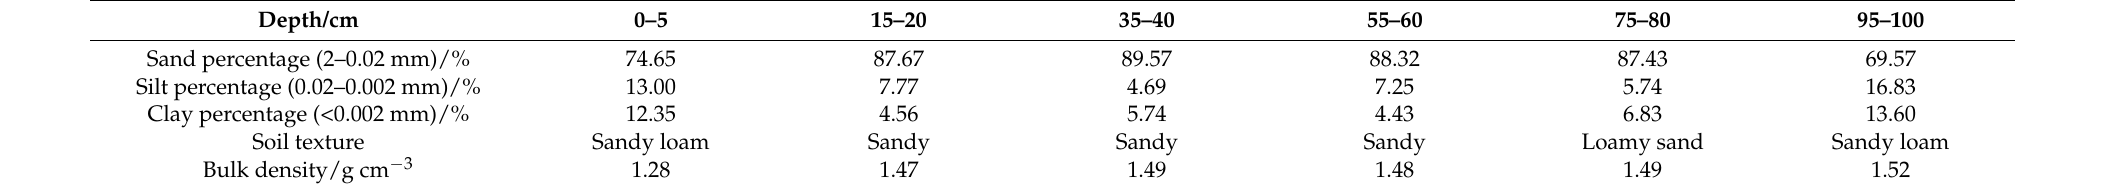
Table 2. Soil texture and bulk density of the top 100 cm of soil in the sampling